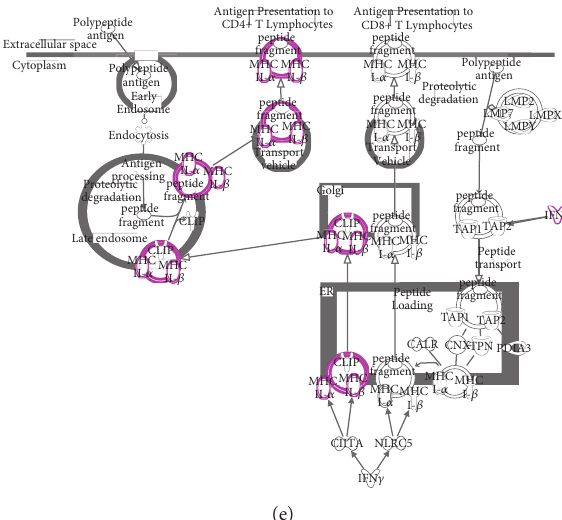
Figure 5: Top five pathways. Purple symbols represent the shared DEGs. (a) Complement system. (b) NF- 𝜅 B signaling. (c) Macropinocytosis signaling. (d) Acute phase response signaling. (e) Antigen